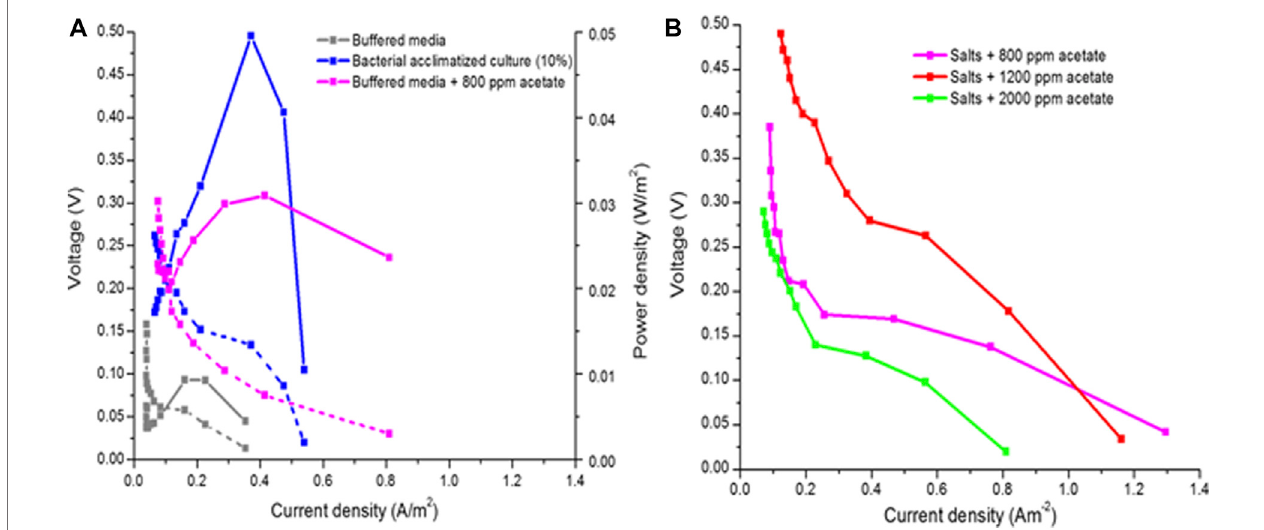
FIGURE 6 | 1 – 4 curves and power density curves of MFC (A) with buffered media alone, with acetate concentration of 800 ppm and with additional suspended bacterial culture of 10% at 30 ° C and 5HRT (B) Imoroved performance with additional salts (NaCl + Na2SO4) and acetate.